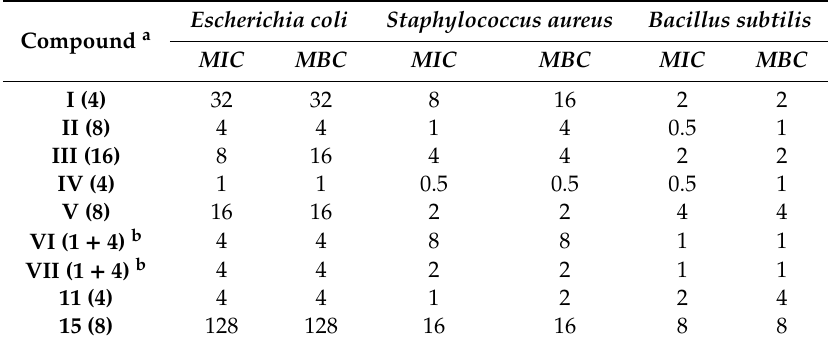
Table 2. MIC and MBC ( µ g / mL) values of the cationic dendrimers ( I – V ), dendrons ( VI – VII ) and bow-ties ( 11 , 15 ) containing imidazolium